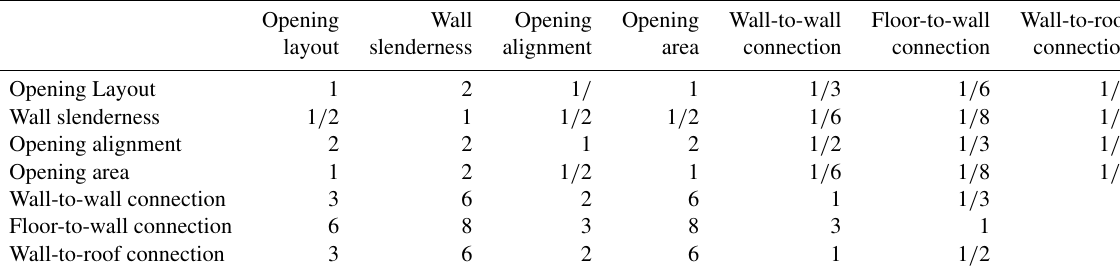
Table A2. Judgement matrix adopted for the calibration of the out-of-plane behaviour weights.